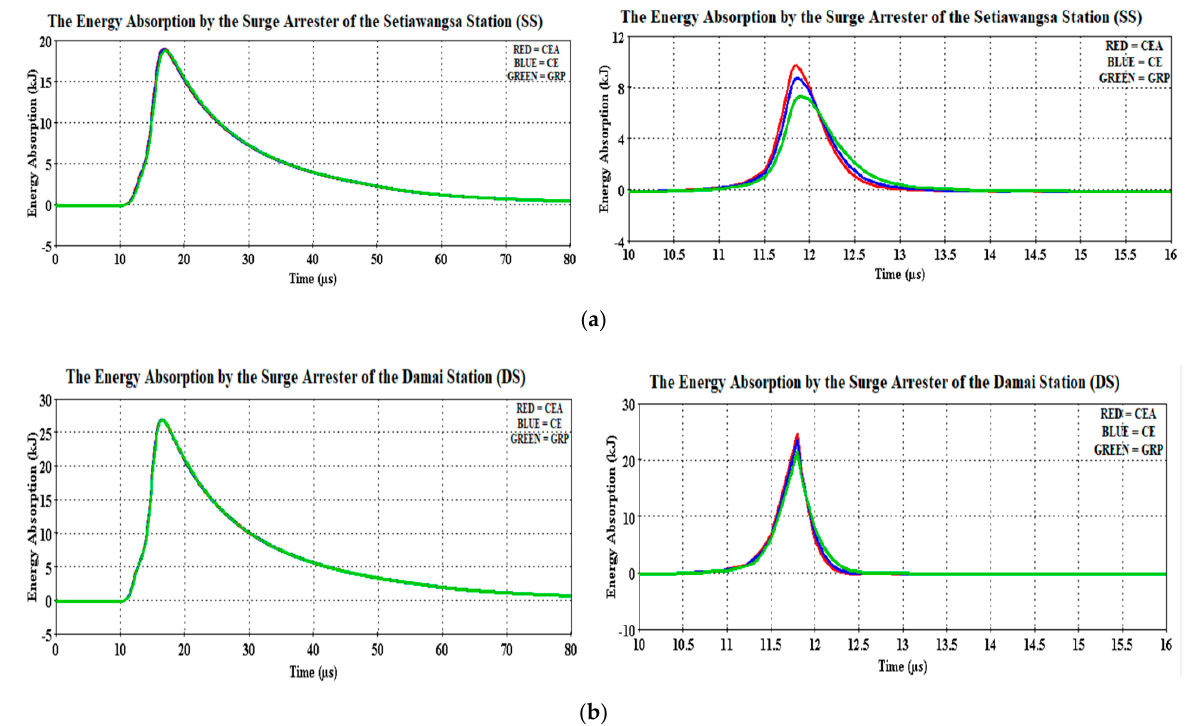
Figure 12. Energy absorption waveforms of the ( a ) Setiawangsa Station and ( b ) Damai Station surge arresters for both 30 kA ( left ) and 90 kA ( right ).